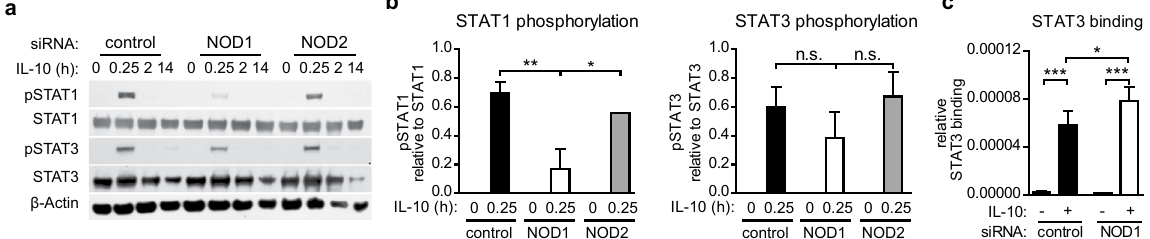
Figure 3. Decreased STAT1 activation, but enhanced STAT3 DNA-binding, upon NOD1 silencing. ( a/b ) Immature DCs were generated and transfected with a control siRNA or siRNA directed against NOD1 or NOD2. STAT activation was analysed by Western Blot. Transfected iDCs were stimulated with IL-10 for the indicated time points and tyrosine phosphorylation of STAT1 and STAT3 was detected by specific antibodies. To control for equal loading, total STAT protein and β -actin were detected. One of two independent experiments ( a ) and quantification of two experiments ( b ) are shown. Data represent mean and SD. ( c ) IL-10 (30 ng/ml)-induced STAT3 binding was analysed after 60 minutes by means of a STAT3 binding assay. STAT3 binding was normalised to total STAT3 protein in the cytosolic fraction, which was measured by Western Blot analysis. Data represent mean and SD of three independent experiments. For statistical analysis a one-way ANOVA with Tukey’s post hoc test was performed.